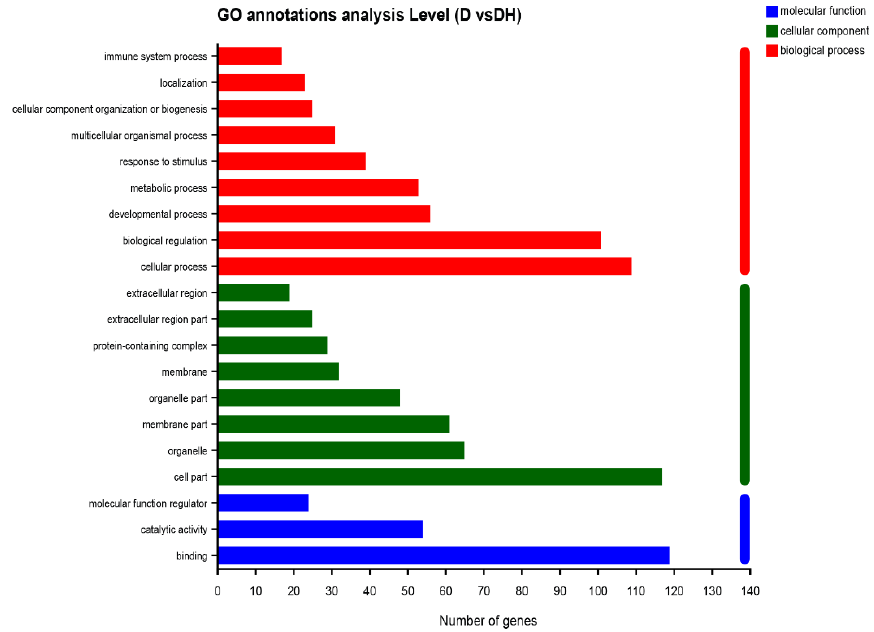
Figure 4. GO enrichment analysis with the differentially expressed genes of groups D and DH.